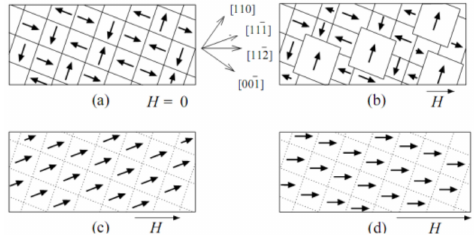
(cid:16) (cid:17) Figure 4. The magnetization process of plane 110 of the Terfenol-D single crystal under the magnetic field in the [112] direction. ( a ) Non-zero spontaneous magnetization state; ( b ) Magnetization caused by the reversible domain wall motion when the input field is low; ( c ) Two irreversible magnetization mechanisms appearanced when the input field increases gradually; ( d ) The magnetization saturation state of the